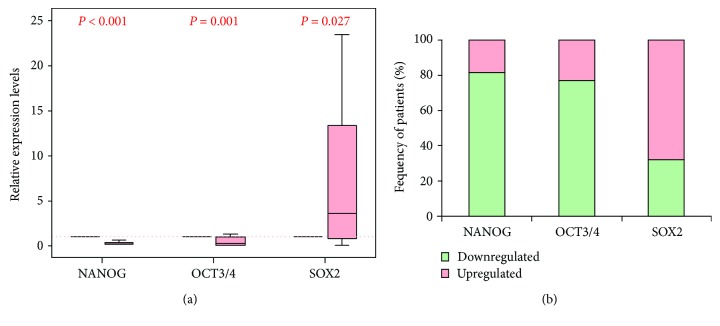
Expression profile of pluripotent genes in GBM patients compared to controls. (a) Values are presented as medians and quartiles of fold change relative to controls. The box defines upper and lower quartiles (25% and 75%, resp.) and the Whisker bars indicate upper and lower adjacent limits. TBP was used as an internal control. Noncancer tissues was set to have a relative expression value of 1.0. Mann–Whitney U test was used for comparison. p value < 0.05 was considered statistically significant. (b) Frequency of patients with up- and downregulated genes.